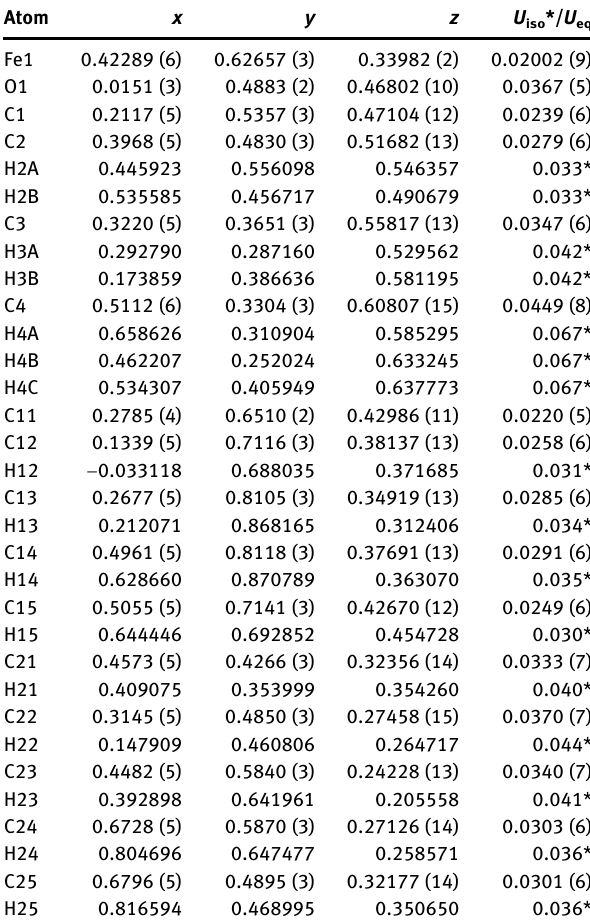
Table  : Fractional atomic coordinates and isotropic or equivalent isotropic displacement parameters (Å 